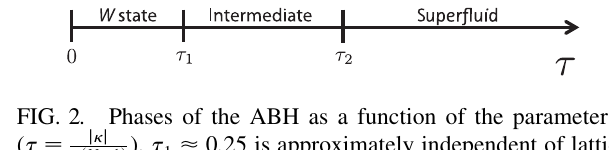
FIG. 3. A plot of Eq. (3) showing the dependence of the ABH on the total number of lattice sites M for M (cid:7) 5 . parameter (cid:4) 2